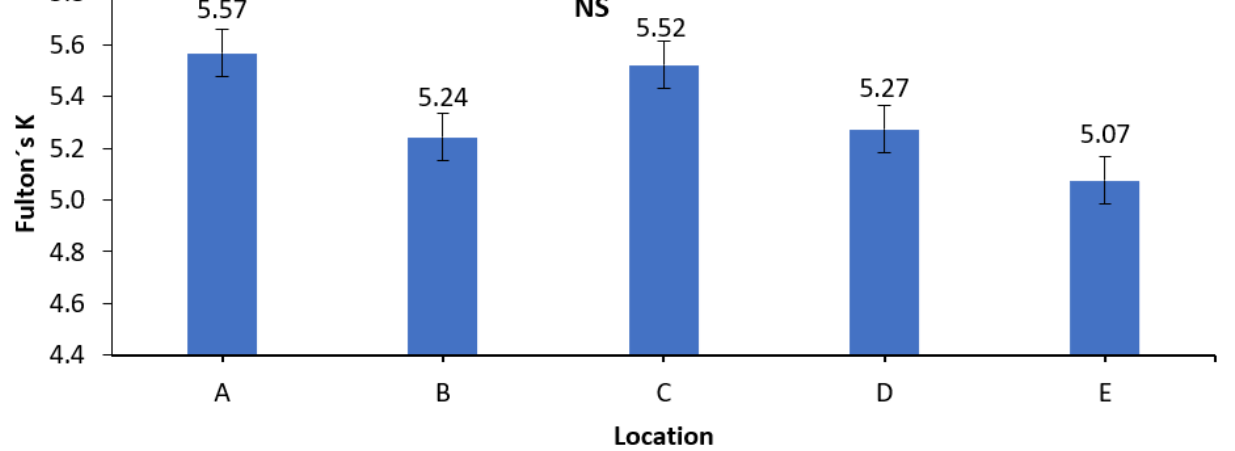
Figure 2. Average Fulton’s K values of lumpfish from five different locations in the Faroe Islands. NS indicates no statistical difference between sampling locations (Tukey’s post hoc test, p > 0.05). Whiskers indicate ± SD.